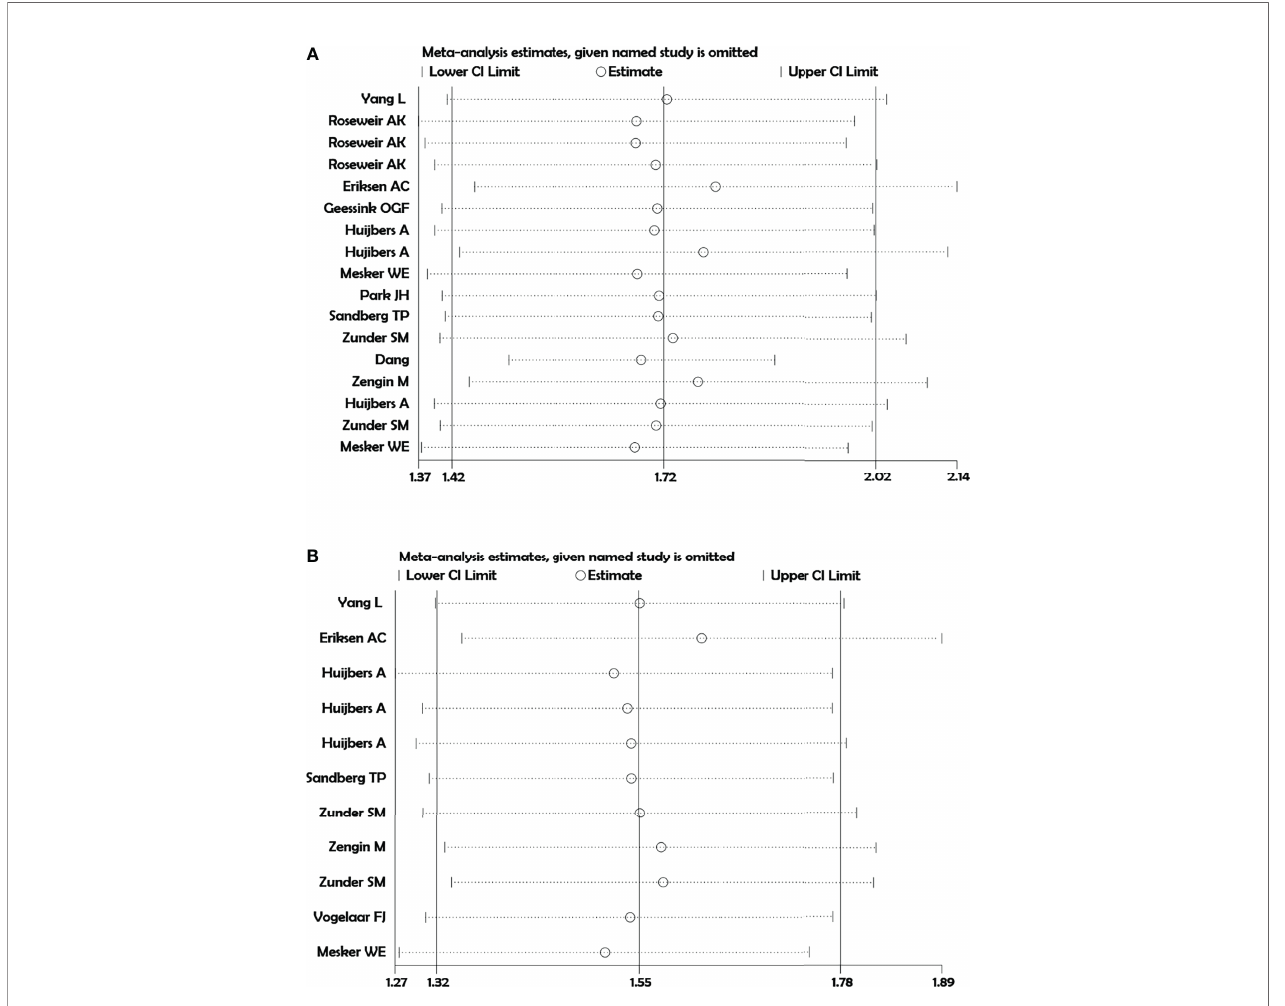
FIGURE 5 | Sensitivity analysis. (A) Disease-free survival. (B) Overall